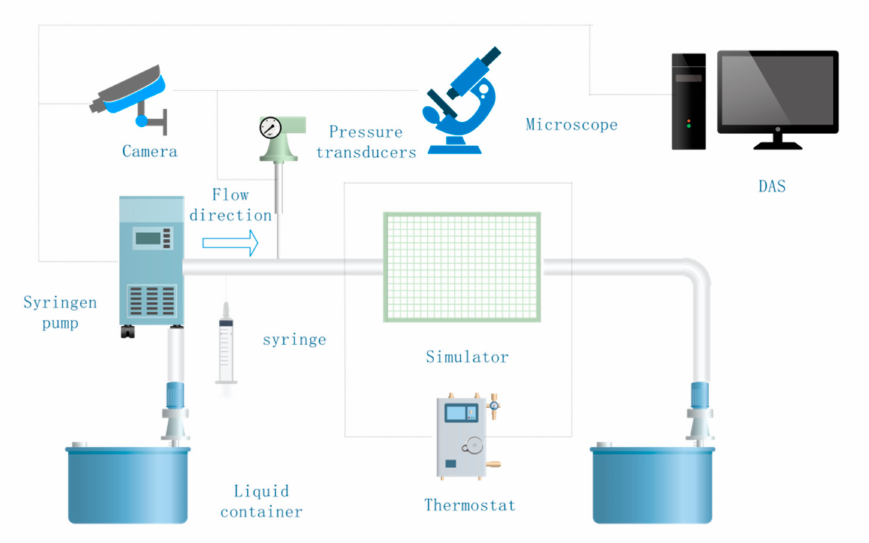
Figure 4. Schematic diagram of the experimental device for particle migration in non-Newtonian fluid bubble